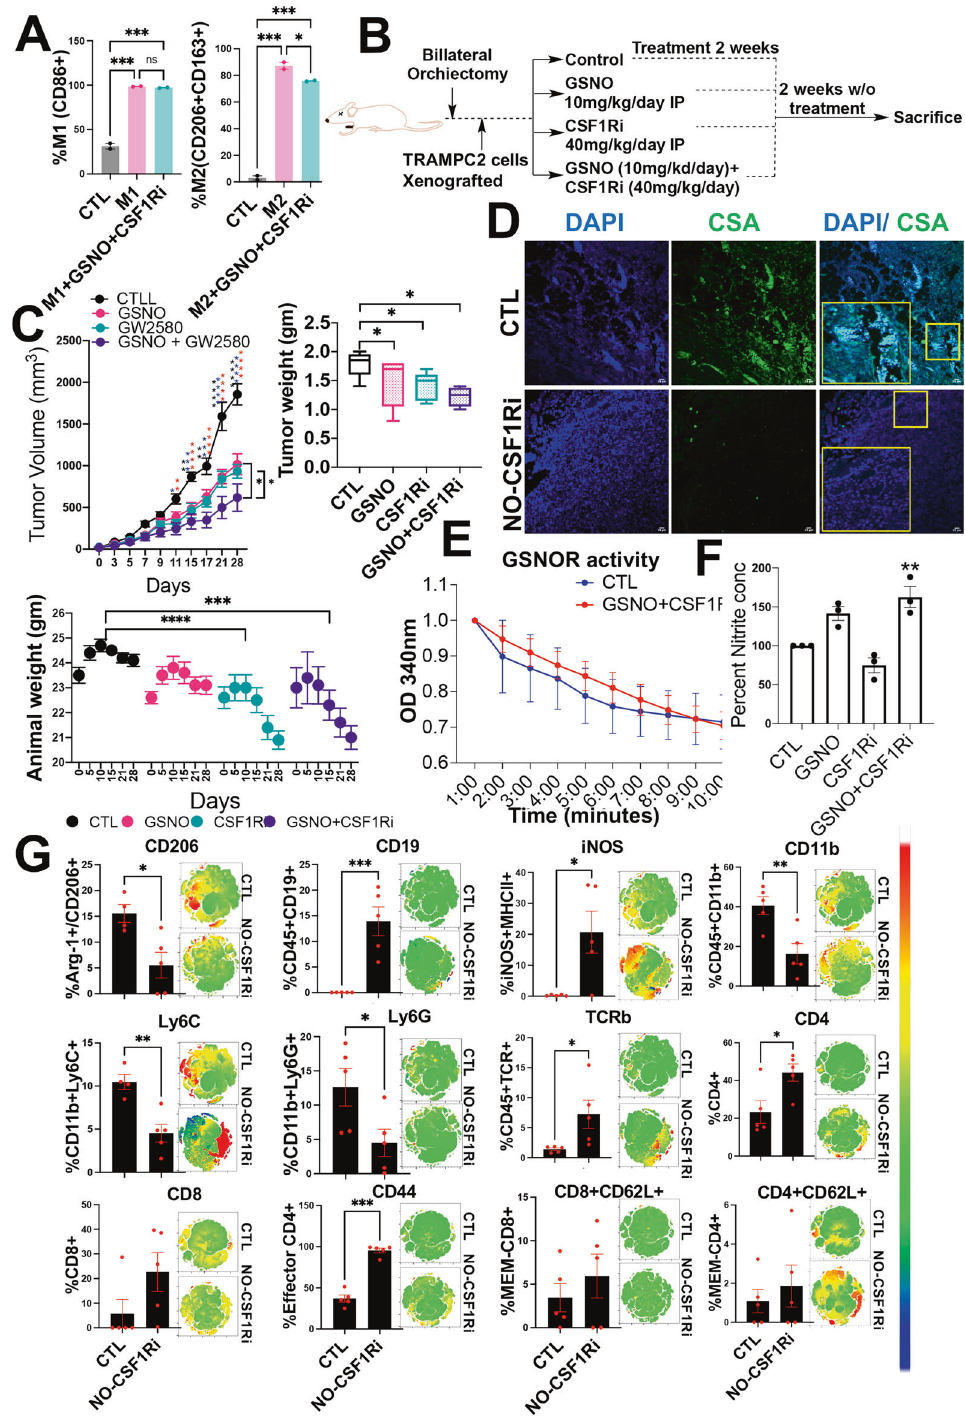
Fig. 7 Impact of NO-CSF1Ri therapy in immune-competent murine models. A Percentage of M1 (CD86 + ) and M2 (CD206 + CD163 + ) macrophages in U937 cells used as a model for macrophage differentiation using speci fi c M1 and M2 cocktails when treated in the presence/ absence of GSNO + CSF1Ri combination. Data are represented as mean ± SEM. *** P < 0.001; ** P < 0.01, * P < 0.05. ns = not signi fi cant. B Experimental plan. C Tumor volume, animal weight, and tumor weight were represented for n = 5 animals per treatment condition. D Representative immuno fl uorescent images for tumor sections for mice treated with vehicle and a combination of GSNO and CSF1R inhibitor (NO-CSF1Ri) and stained with 4 ′ ,6-diamidino-2-phenylindole (DAPI) (blue), and Cysteine sul fi nic acid (red) ( n = 3). E GSNOR activity was measured at 340 nm for 10 minutes using tumor lysates treated with a vehicle and a combination of GSNO and CSF1R inhibitor ( n = 3). F Percent nitrite concentration under different treatment conditions as estimated using the Griess test in tumor lysates ( n = 3). G Immune- phenotyping done in tumor cells in untreated and NO-CSF1Ri mice ( n = 5) for various markers: CD206, CD19, iNOS, CD11b, Ly6C, Ly6G, TCRB, CD4, CD8, CD44, and CD62L respectively. Data are Mean ± SEM. *** P < 0.001; ** P < 0.01, * P < 0.05.